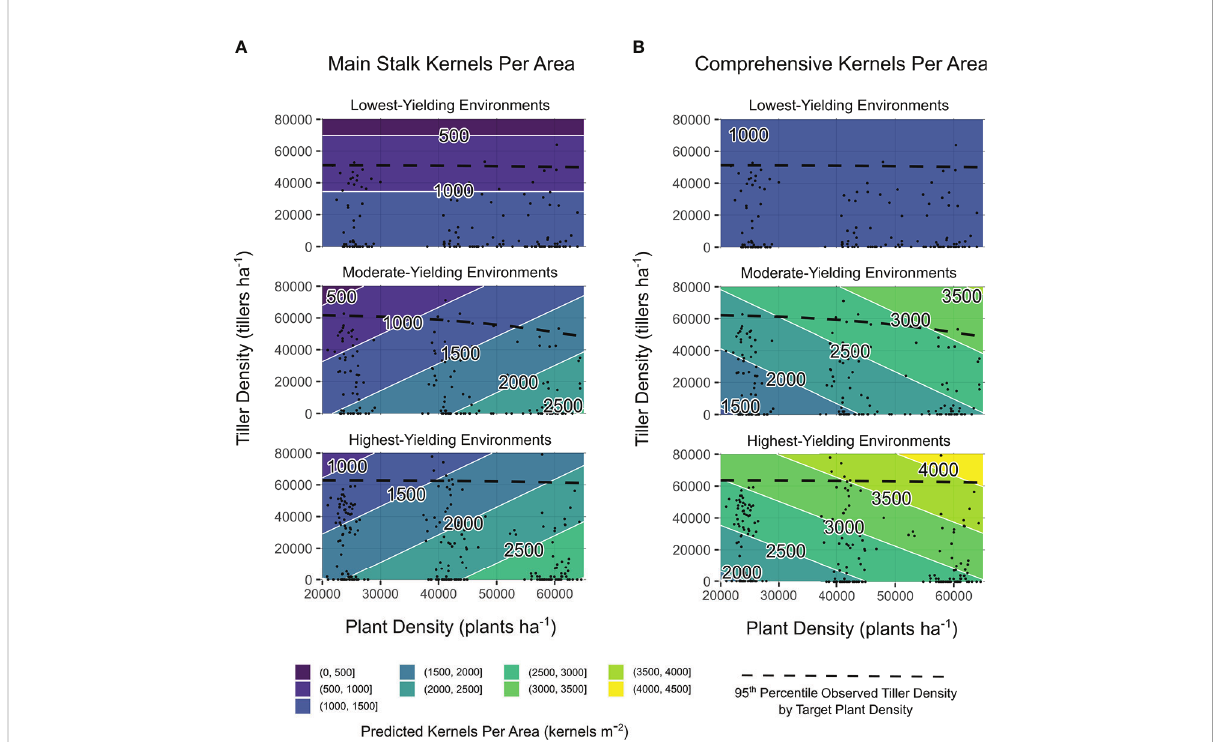
FIGURE 4 Main stalk kernels per area (A) and comprehensive kernels per area (B) predictions from models of observed plant density, tiller density, and yield environment as determined by analysis shown in Supplementary Table 3. Site-years are grouped by realized yield environment. Contours are shaded and labeled according to 500 kernels m − 2 density intervals. White lines indicate a change in kernel density interval. Observed plant densities and tiller densities are indicated with black points. Black dashed lines are intended as an informal visual indicator of tiller expression potential for each yield environment. Extrapolations beyond black points and dashed black lines are shown for the purpose of comparing environments on the same density